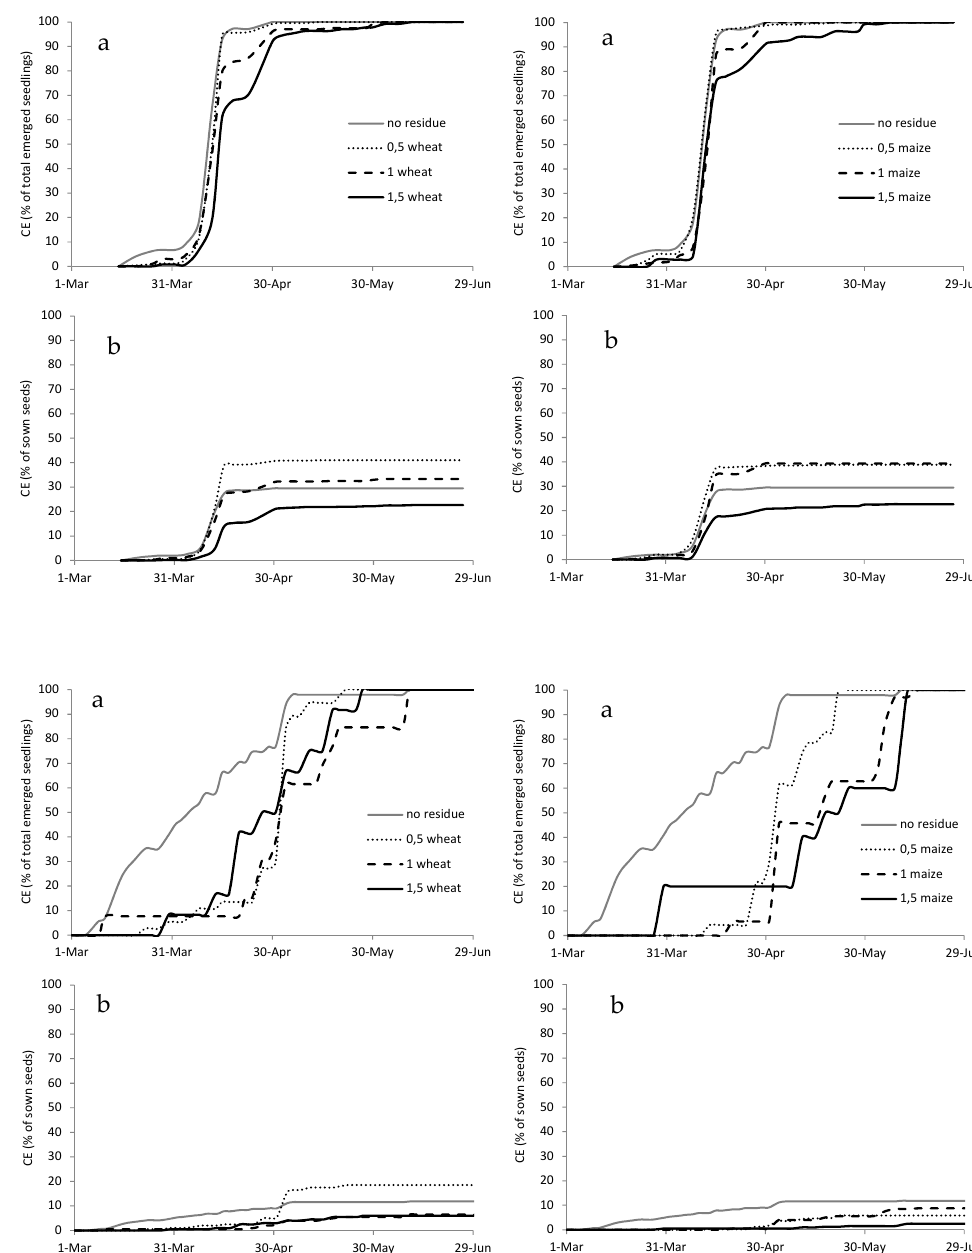
Figure A1. Cumulated emergence (CE) expressed as percentage of total emerged seedlings ( a ) and as percentage of sown seeds ( b ) of Abutilon theophrasti in 2019 and 2020 with different types (wheat on the left and maize on the right) and amounts of crop